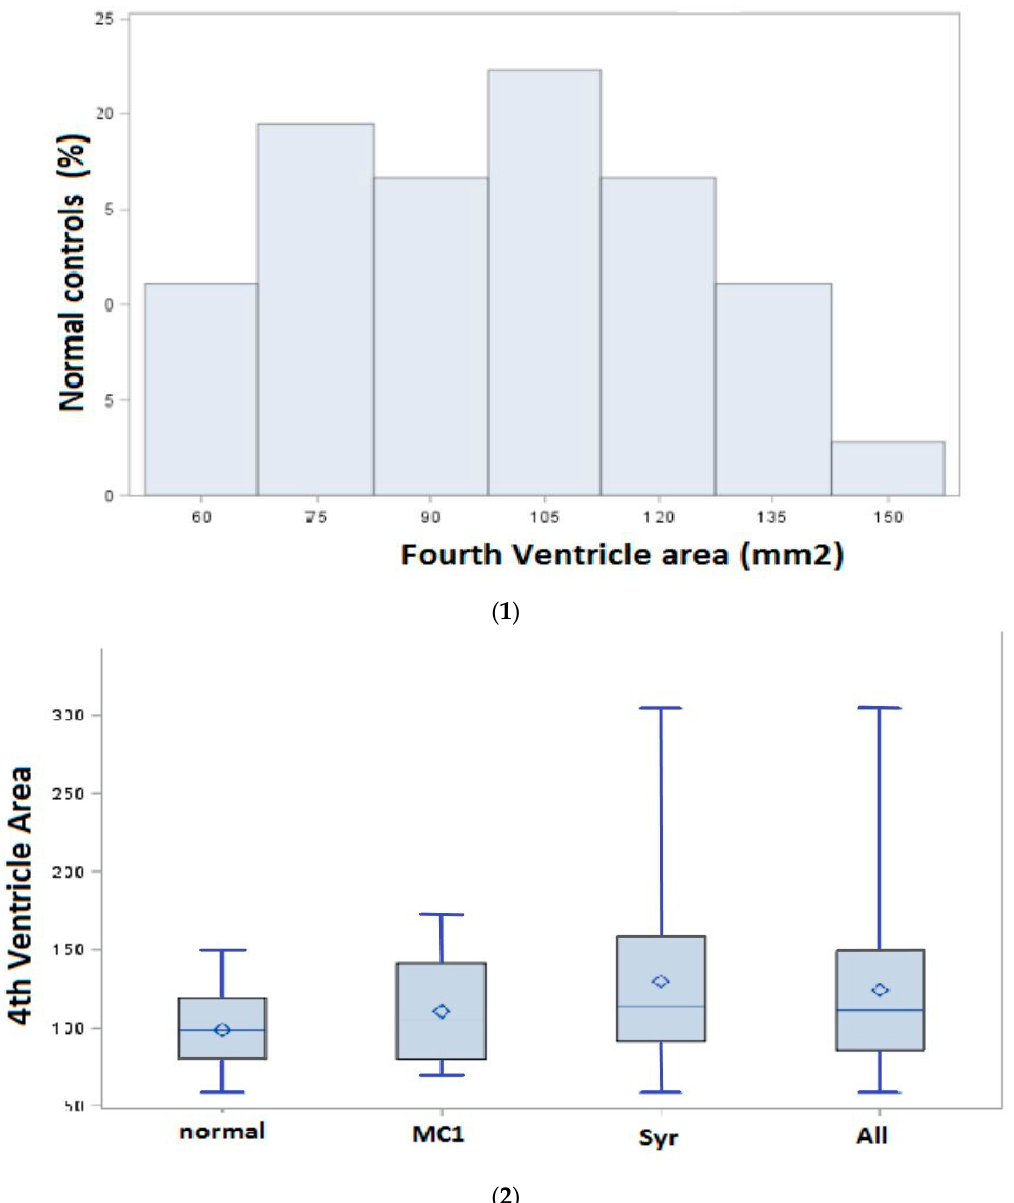
Figure 1. ( 1 ). Fourth ventricle area in normal control group (the graph shows the distribution of the fourth ventricle area (in mm 2 ) in 36 normal controls, as measured in the midsagittal plane at T1-weighted MRI); ( 2 ) fourth ventricle area in patients (presurgery) as compared with normal controls. Boxplots of the fourth ventricle area show the shift in patients with Chiari 1 malfor- mation (CM1), syringomyelia with CM1 (Syr), and all patients (All) at T0 (presurgery) compared with normal controls. There are significant differences in the mean fourth ventricle area between groups. The mean fourth ventricle area in Syr (129.8 mm 2 , SD 57.9, range 58–305, p = 0.03 ) Bold face characters indicate statistically significant differences and in All (124.2 mm 2 , SD 52.6, range 58–305, p = 0.04 ) is significantly increased compared with normal controls (98.7 mm 2 , SD 24.7, range 58–149). There was no significant difference in the mean fourth ventricle area in CM1 (110 mm 2 , SD 34.7, range 69–172) compared with normal controls ( p = 0.38). Bold face characters indicate statistically significant